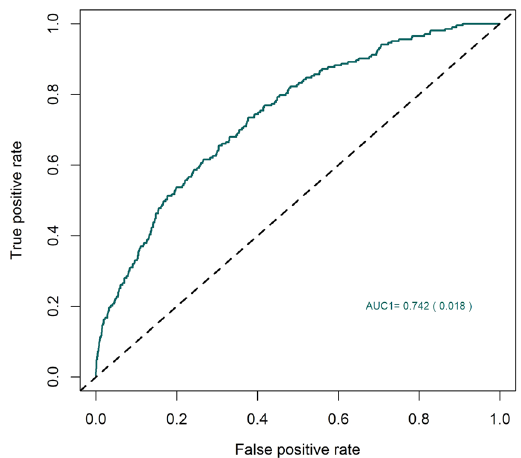
Fig. 5 The predictive value of a genetic testing model based on common polymorphisms in an independent European case-control cohort. The area under the receiver operating characteristic curve for the performance of a keratoconus predictive model that used the SNPs identi fi ed through the multi-ethnic analysis. The model was trained in the discovery populations of European ancestry and was replicated in a completely independent European panel of 222 keratoconus patients and 2208